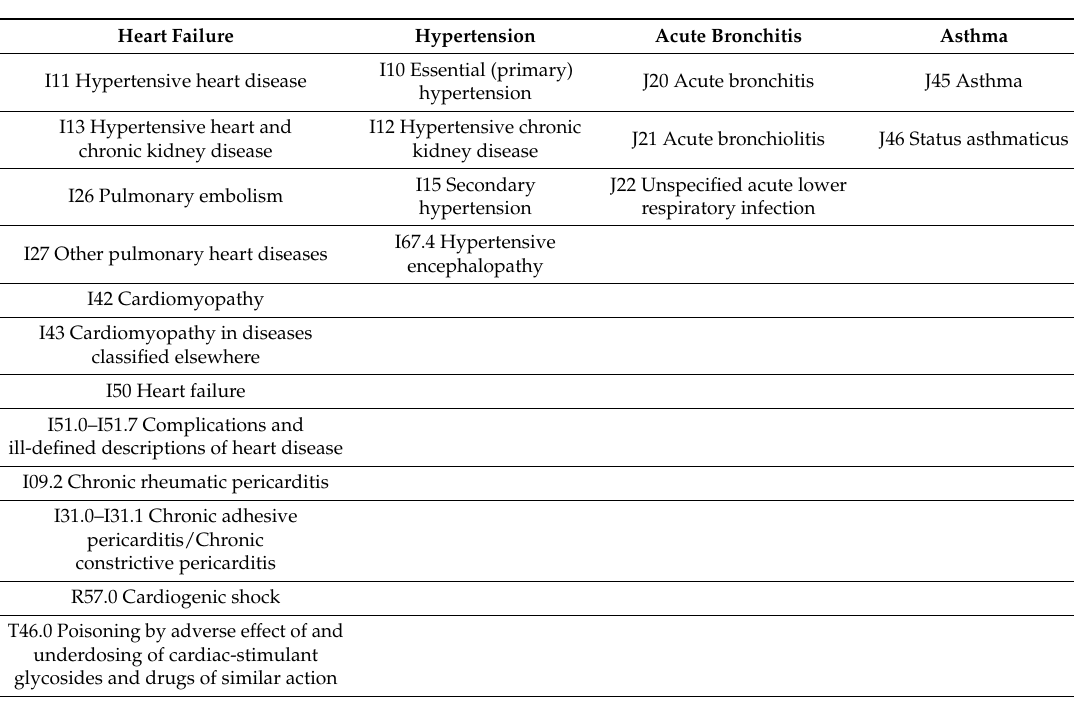
Table 1. Classification of all health outcomes analyzed in this study by ICD-10 (International Classification of